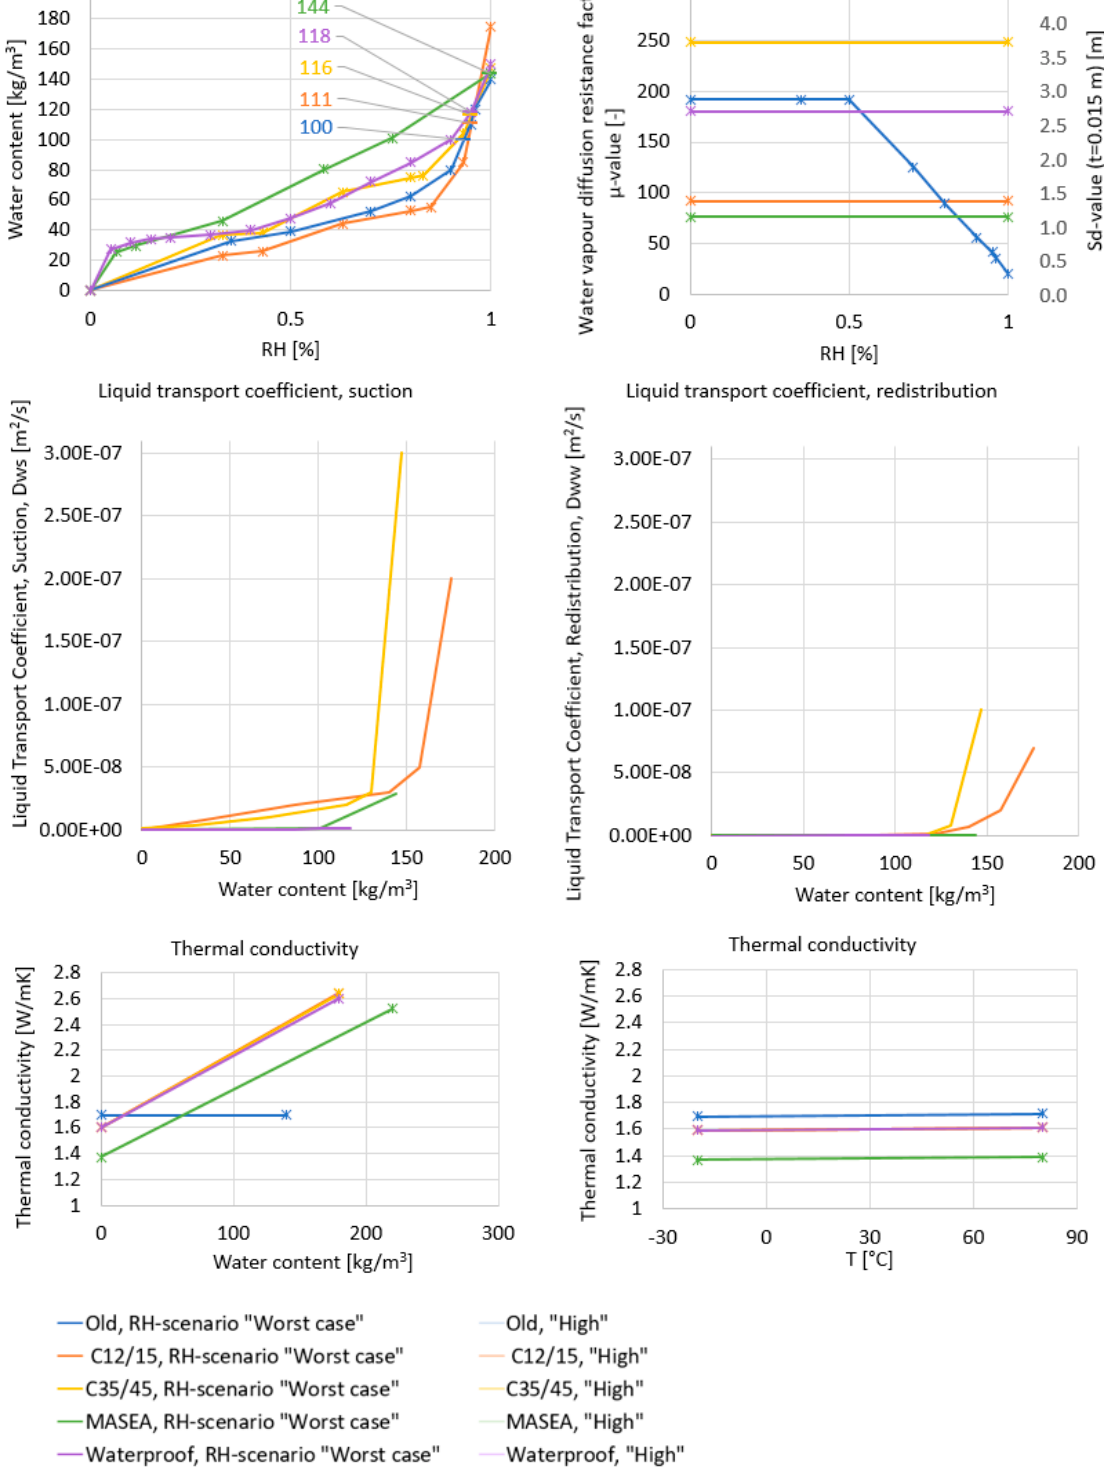
Figure A1. Material properties of the five types of concrete used in the simulations. The graphs are created by the authors based on selected material data from the WUFI ® Pro material database [17].